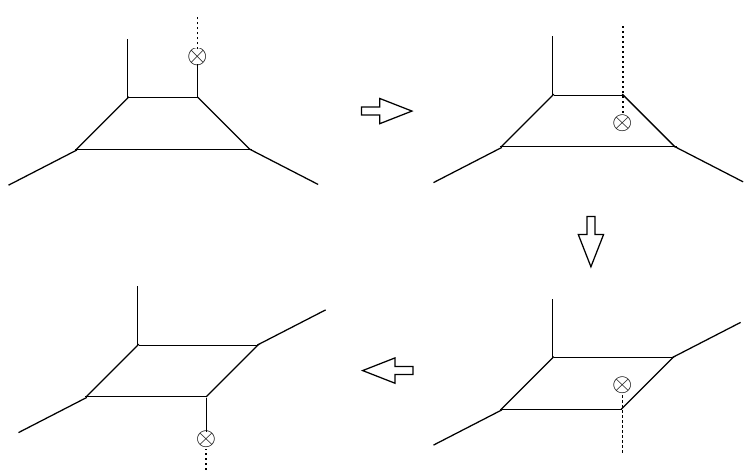
symbol denotes the location of a (cid:10)